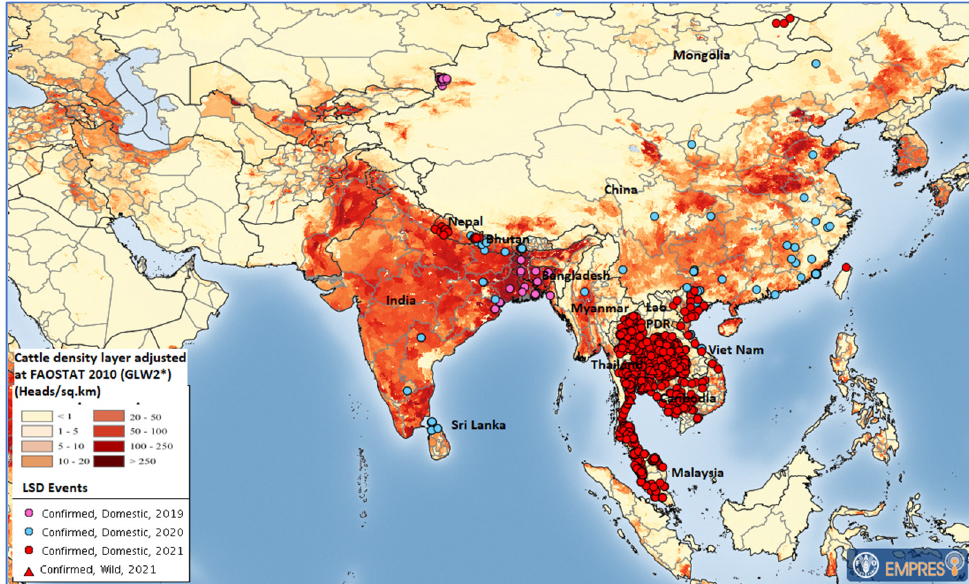
Figure 1. Locations of confirmed LSD outbreaks in Asia from 2019 to December 2021 (map source: FAO Emergency Prevention System Global Animal Disease Information System (EMPRES-i); data: OIE and national authorities; cattle density layer source: GLW2*: The Gridded Livestock of the World, Version 2, 2014, https://journals.plos.org/plosone/article?id=10.1371/journal.pone.0096084 (accessed on 21 April 2022). Maps disclaimer: The boundaries and names shown and the designations used on these map(s) do not imply the expression of any opinion whatsoever on the part of FAO concerning the legal status of any country, territory, city, or area, or of its authorities, or concerning the delimitation of its frontiers and boundaries. Dashed lines on maps represent approximate border lines for which there may not yet be full agreement. FAO Regional Office for Asia and the Pacific (RAP) has verified that all maps contained in the work are in conformity with UN maps, and FAO RAP accepts all responsibility in the event of reputational damage to FAO or FAO member countries as a result of inappropriate boundaries.